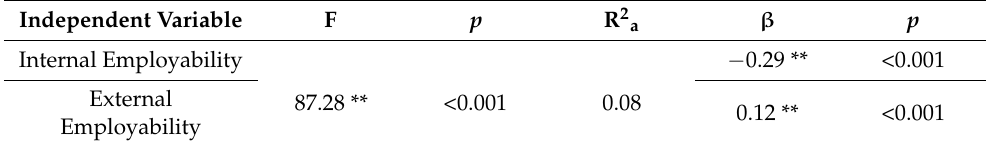
Table 3. Multiple linear regression results (H2 e H3).